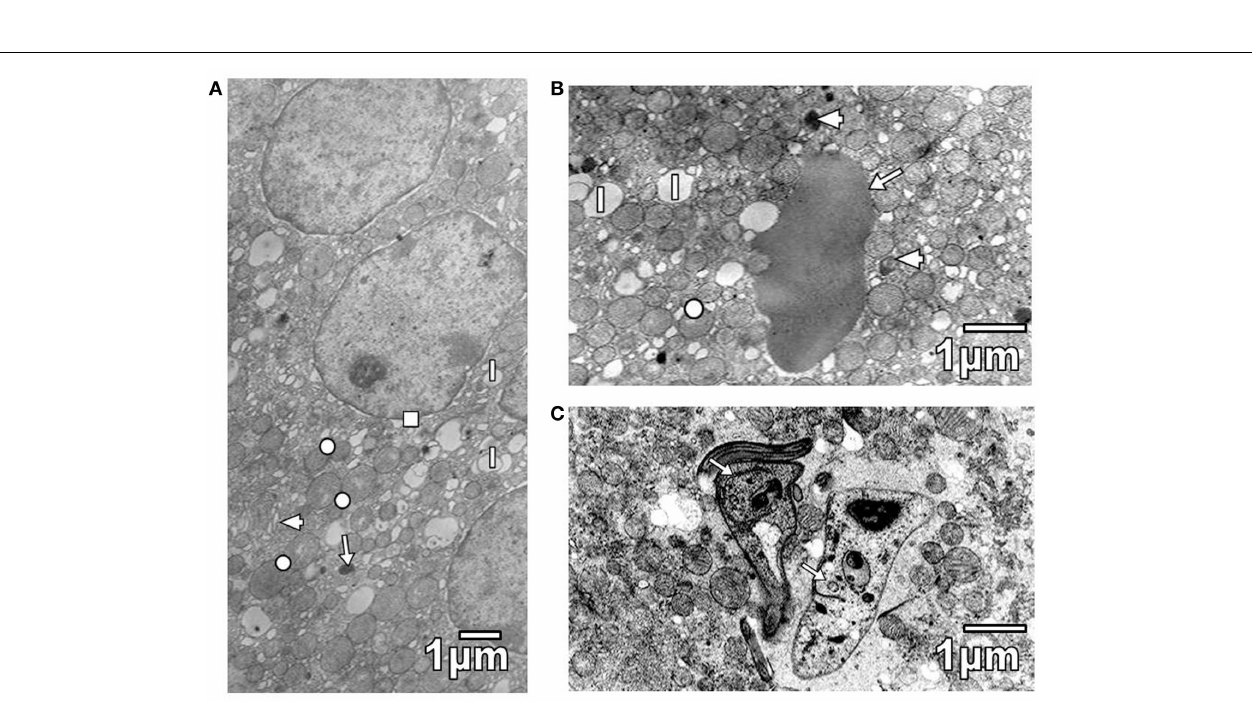
variable number of cristae (circle), lipid droplets (l), and lysosomes (arrowheads). Note the presence of an erythrocyte (arrow). (C) Section of a cortical cell from a mouse parasitized with T. evansi is shown . Observe the presence of parasites (arrows).